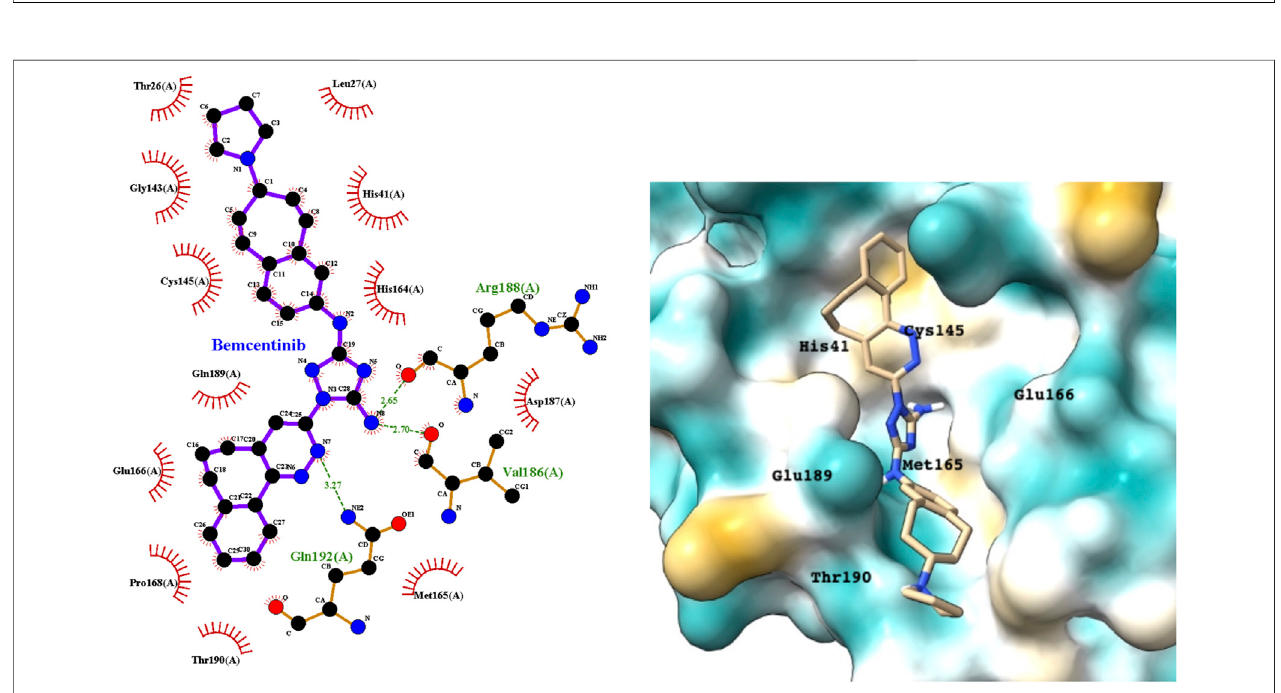
FIGURE 4 | LigPlot (left) and hydrophobic protein surface representation (right) of the main interactions between M pro and bemcentinib. The molecular surface denotes hydrophobicity of the pockets (blue hydrophilic, yellow/brown hydrophobic). Key binding site residues are labeled to help orient the viewer.